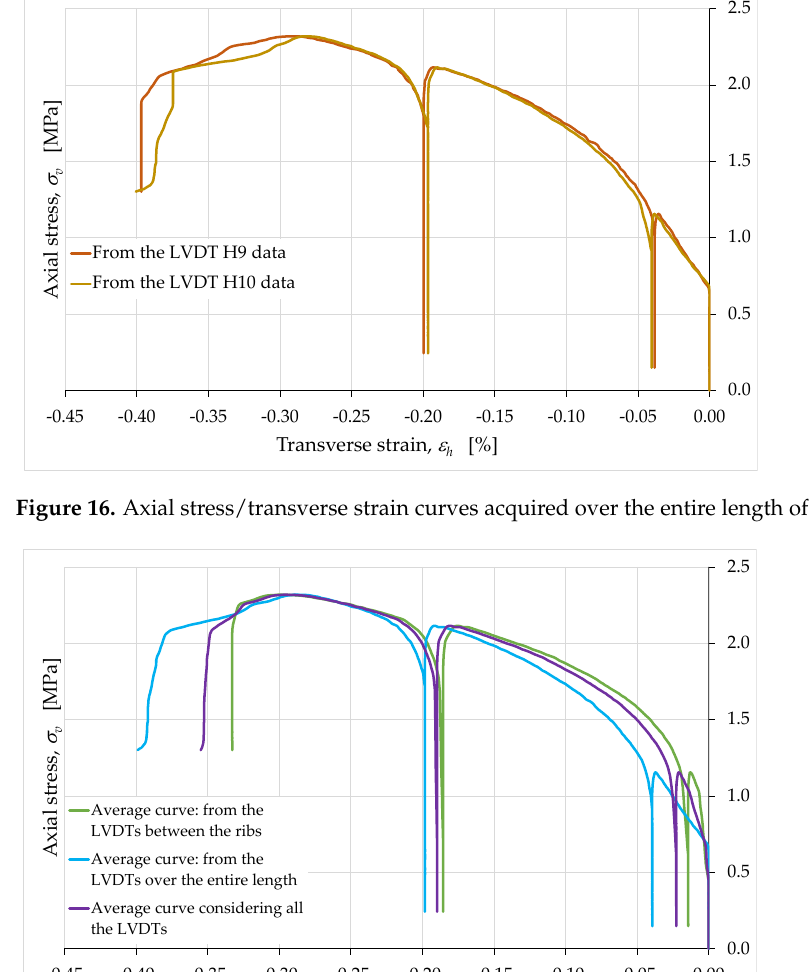
Average curve: from the LVDTs between the ribs Average curve: from the LVDTs over the entire length Average curve considering all the LVDTs